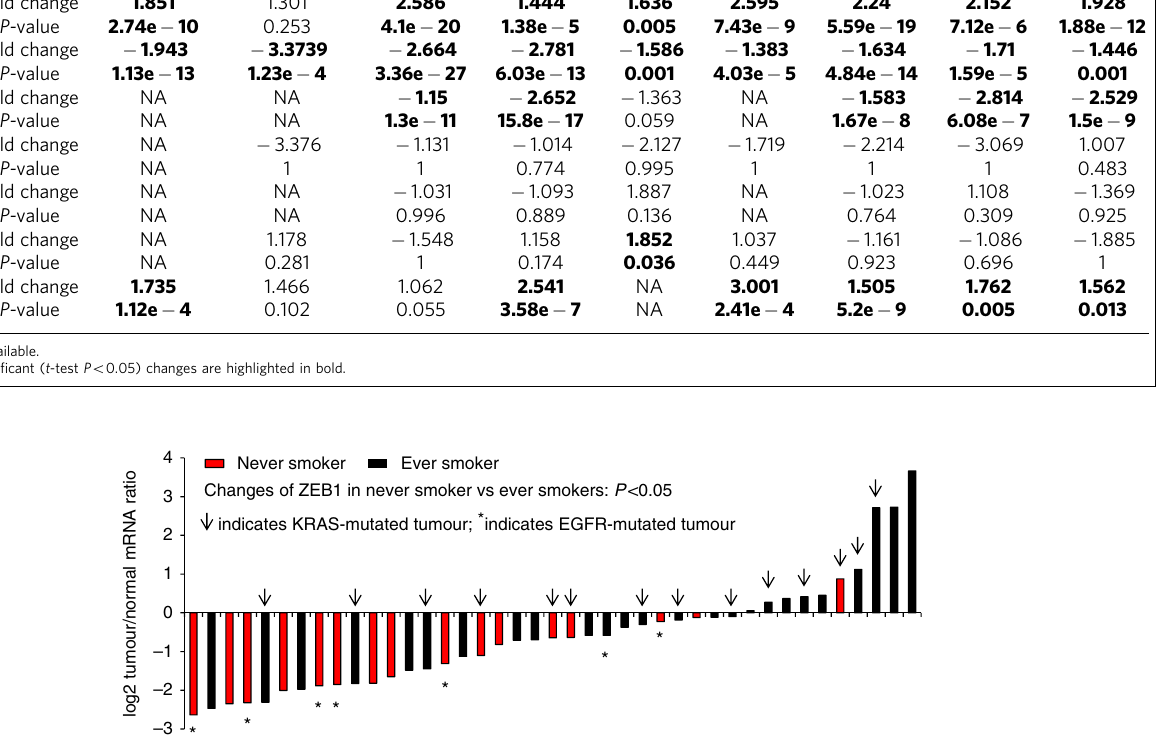
Figure 1 | The changes of ZEB1 expression in lung adenocarcinomas compared with normal lung tissues are associated with smoking status. The mRNA levels of ZEB1 in 41 pairs of lung adenocarcinomas and normal lung tissues (Supplementary Table 1) were quantified by qPCR and normalized to that of L32 (internal control). The changes in ZEB1 expression were expressed as logged (log2) ratios of ZEB1 level in tumours versus normal tissues. Note: arrow indicates KRAS-mutated tumours and * indicates EGFR-mutated tumours.